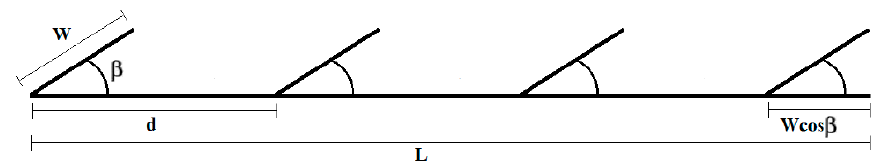
Figure 4. PV tilted system layout options based on roof space constraint in system sizing [2].